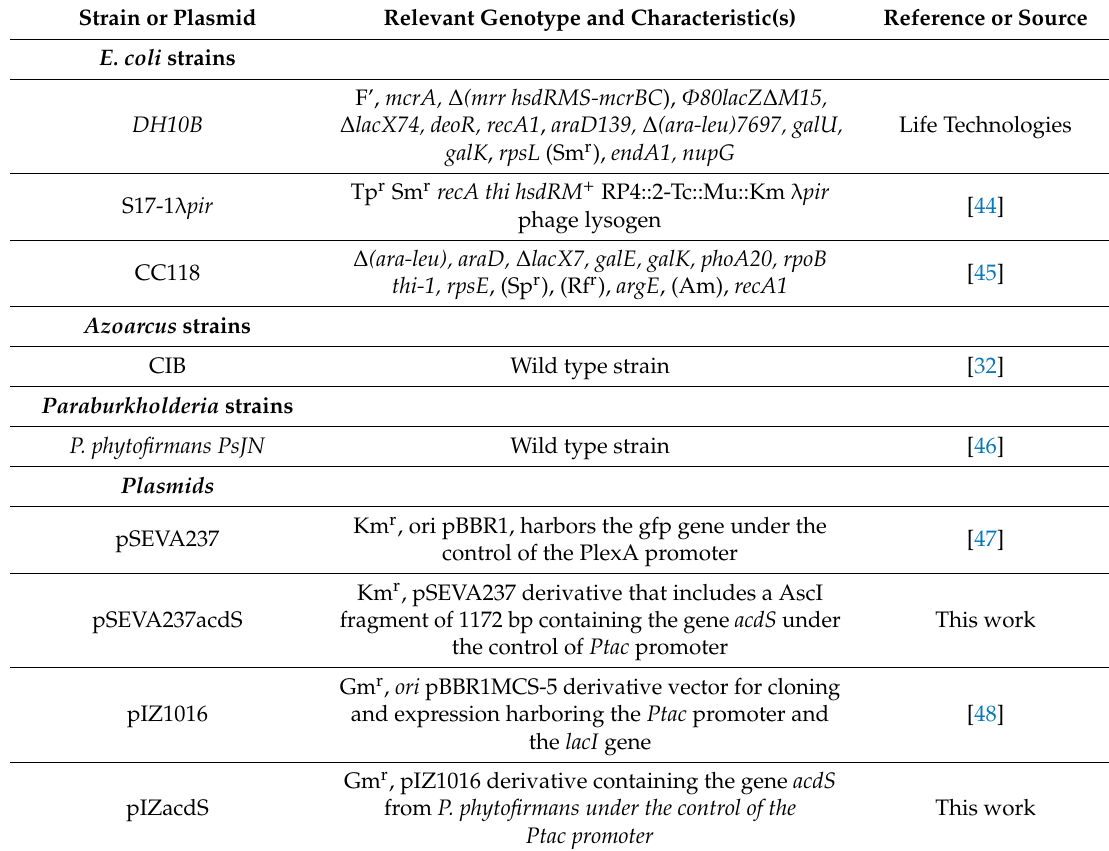
Table 1. Bacterial strains and plasmids used in this